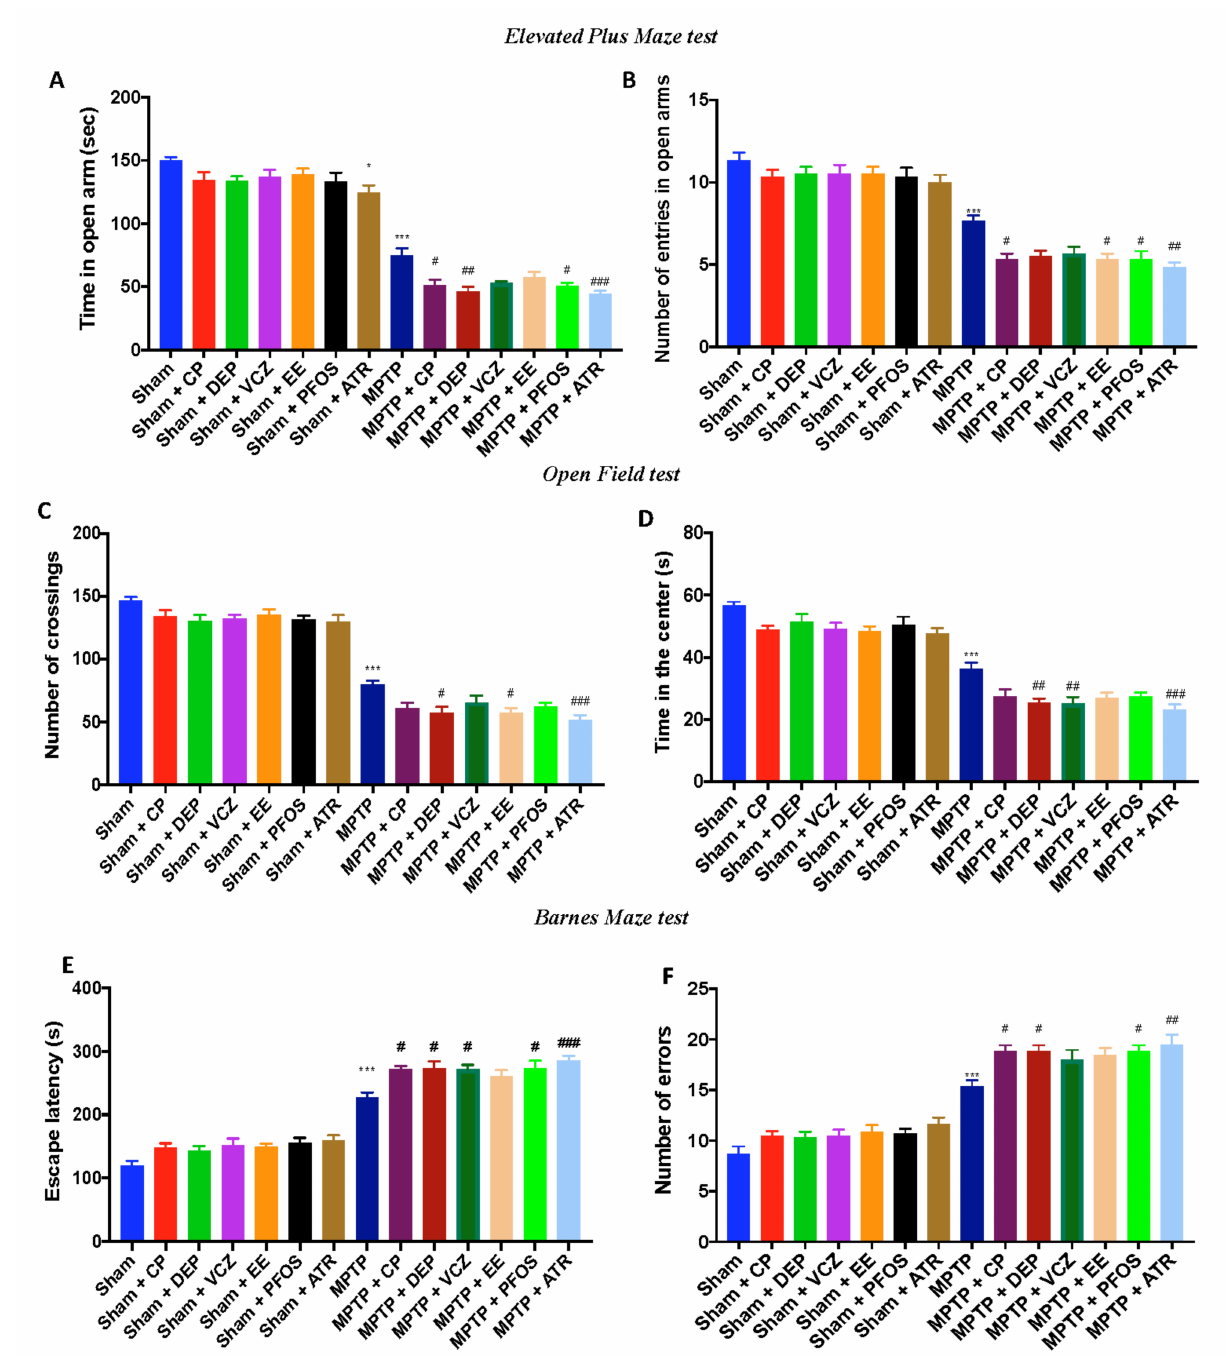
Figure 9. Behavioral analysis for cognitive alteration: Elevated Plus Maze test ( A , B ); Open Field test ( C , D ); Bernes Maze test ( E , F ). Data are expressed as the mean ± SEM of N = 6 mice/group. * p < 0.05 vs. sham; *** p < 0.001 vs. sham; # p < 0.05 vs. MPTP; ## p < 0.01 vs. MPTP; ### p < 0.001 vs.